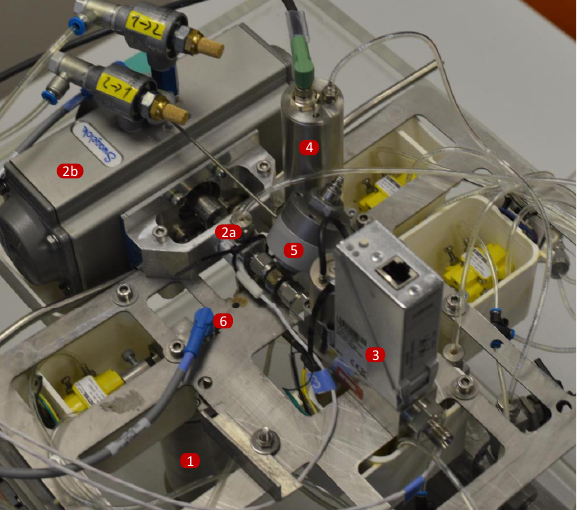
Figure 4. Photograph of the system taken during maintenance. Labelled essential components: (1)—Cylinder part of V mea , (2a)—valve V0, (2b)—actuator for V0, (3)—mass flow contoller, (4)— p dif pressure transducer, (5)— p div pressure sensor, (6)— T mea temperature